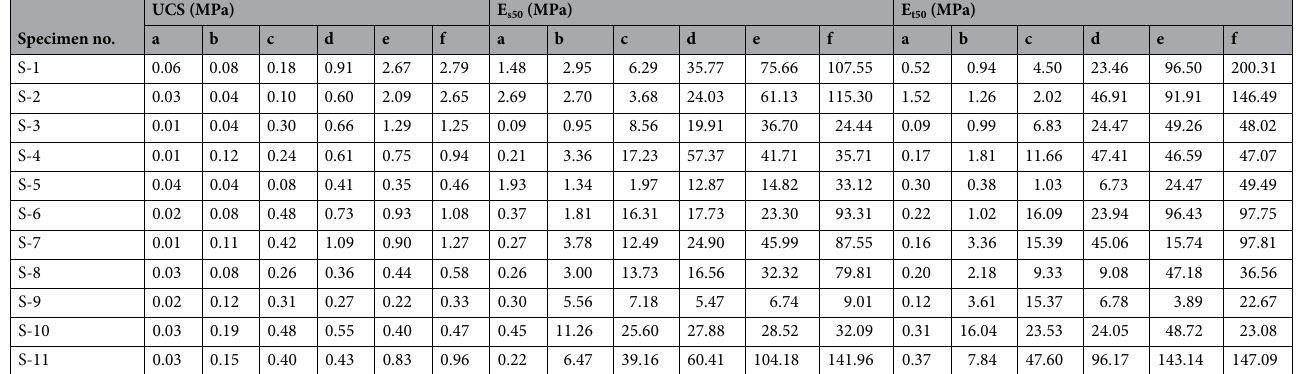
Table 4. Values of UCS, E s50 , and E t50 determined from stress–strain curves for each specimen. E s50 is the secant modulus at 50% ultimate strength, and E t50 is the tangent modulus at 50% ultimate strength.